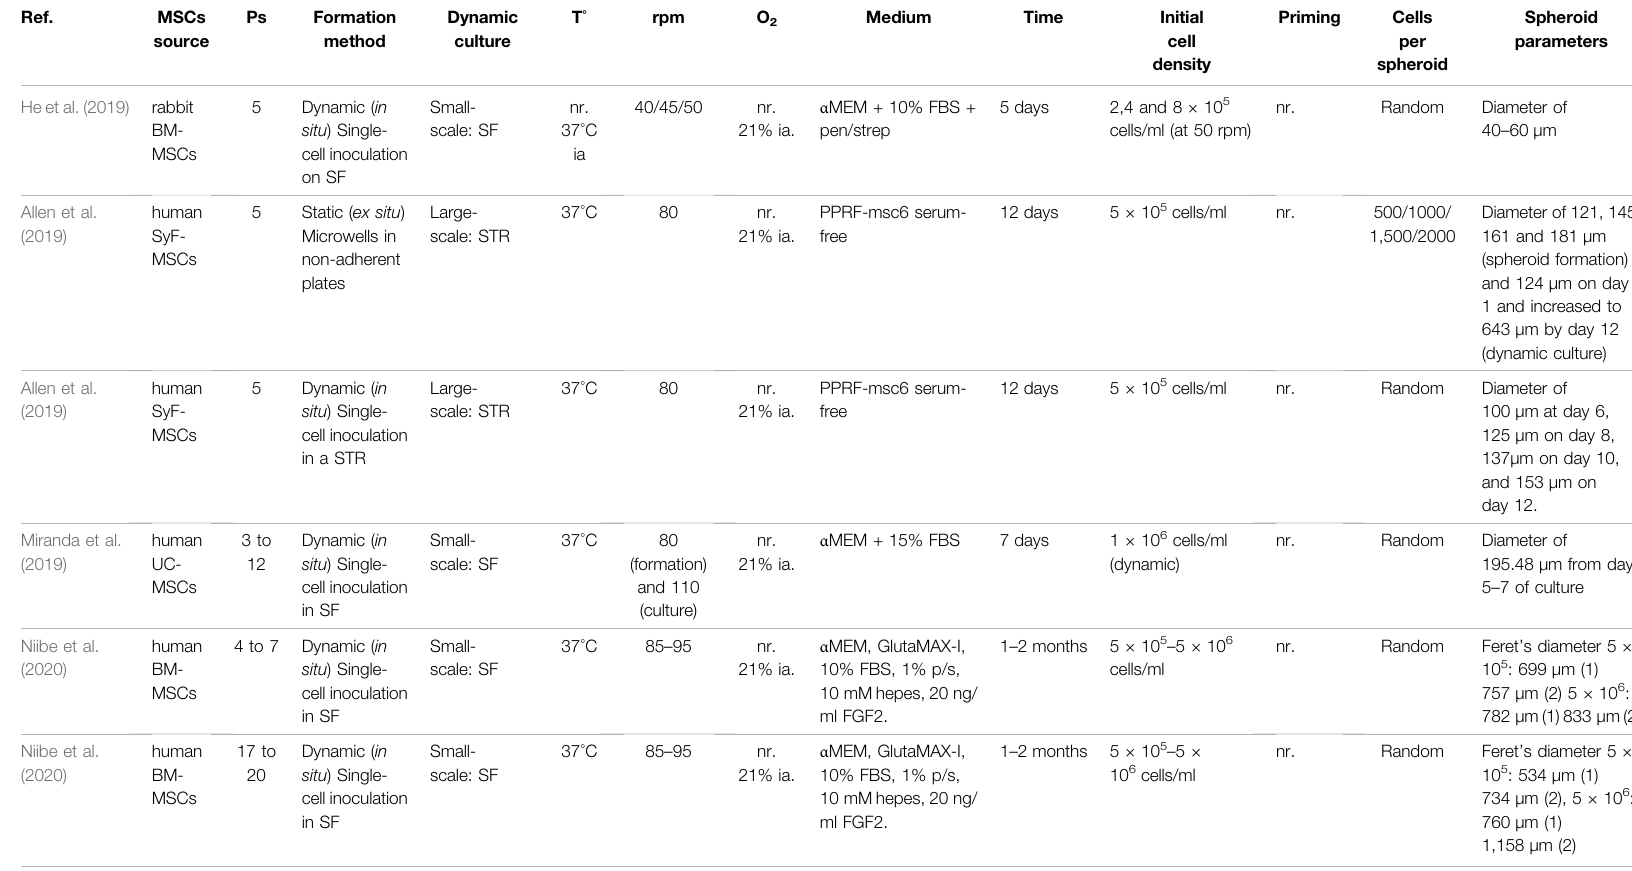
TABLE 1 | ( Continued ) Comparison of different studies reporting static and dynamic methods of spheroid formation and their results for the dynamic cultivation of MSC spheroids.